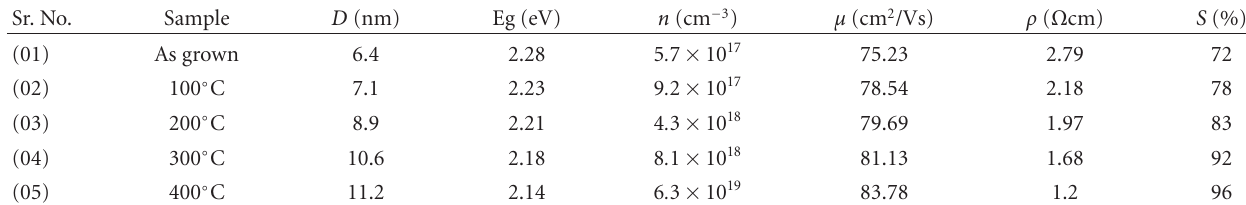
Table 1: The parameters of physicochemical and optoelectronic characteristics of as grown and annealed thin films of Ag doped nanostructured CdS prepared by cost e ff ective chemical route at room temperature. Sr. No.